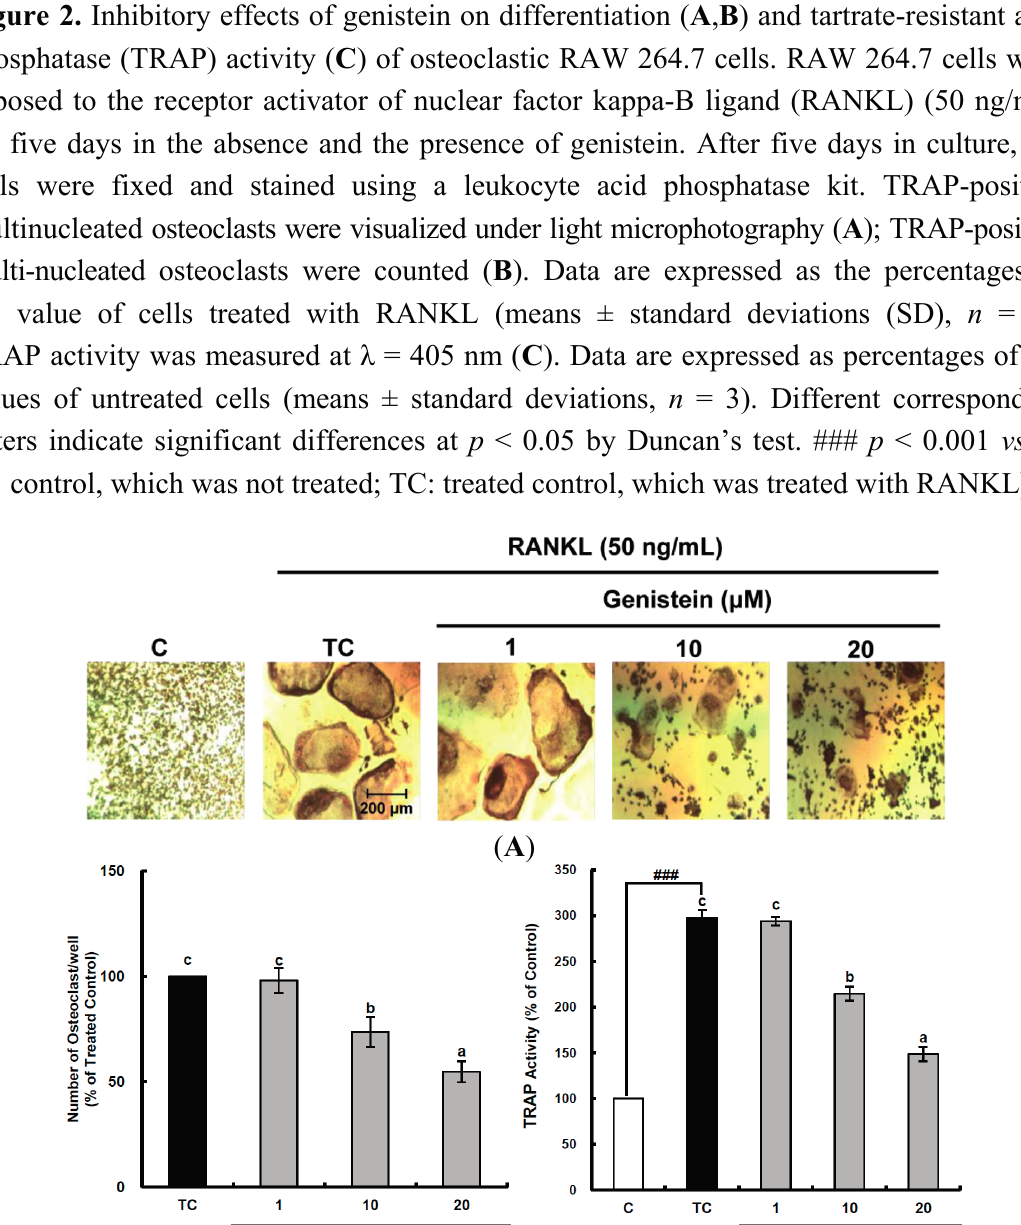
2.3. The Suppressive Effect of ROS Level by Genistein during the Osteoclastic Differentiation of RAW 264.7